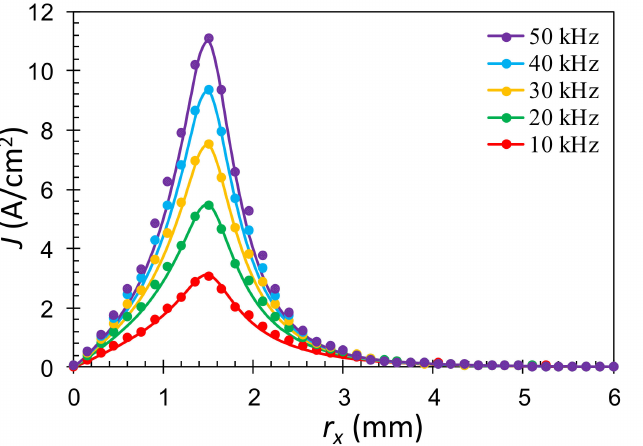
Figure 10. Amplitude of the eddy-current density along the x-axis on the surface of a flawless aluminum slab at frequencies of 10, 20, 30, and 40 kHz calculated by the MATLAB software (solid curves) and the ANSYS software (solid circles). The excitation coil has a radius of 1.5 mm, a height of 0.05 mm, and a lift-off distance of L 1 = 0.2 mm. The surface current density of the excitation coil is ζ = 800